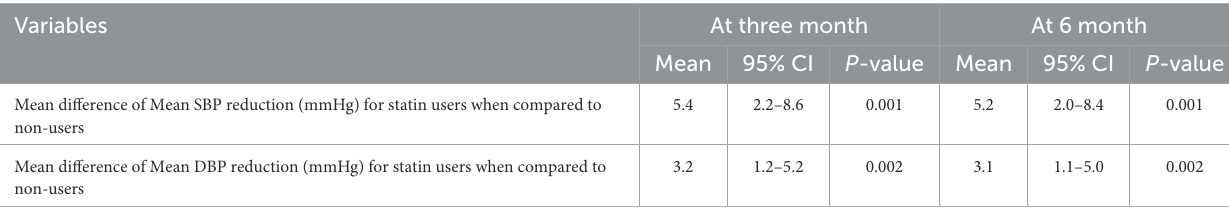
TABLE 7 T -test result for statin users versus non-users in terms of BP reduction from baseline (pre-drug BP value) of patients with hypertension attending the outpatient clinic at FHCSH, northwest Ethiopia. Variables At three month At 6 month Mean 95% CI P -value Mean 95% CI P -value